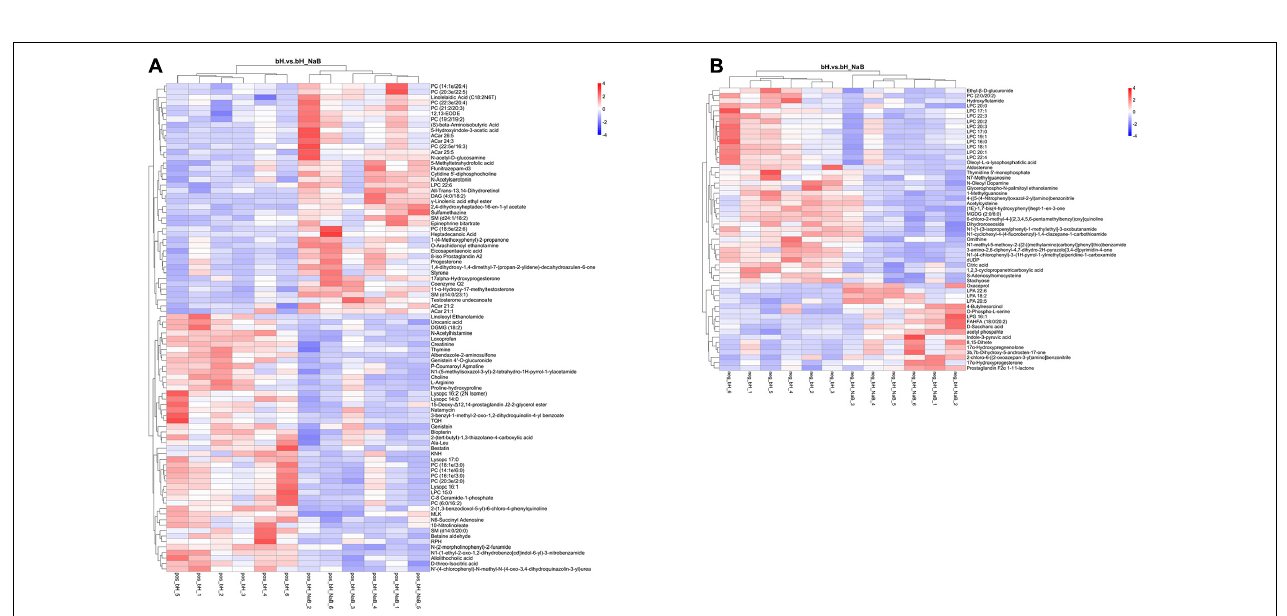
FIGURE 8 | Hierarchical clustering analysis of the DMs in bH vs. bHNaB: positive (A) and negative (B) ions. Red and blue indicate that the DMs were upregulated and downregulated, respectively.